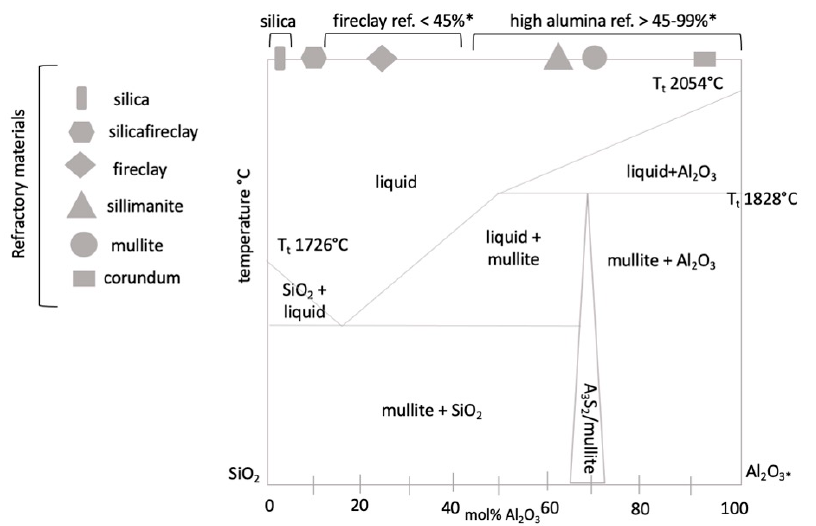
Figure 2. Categorization of basic refractory materials in binary diagram of SiO 2 -Al 2 O 3 . Note: * the amount of Al 2 O 3 .